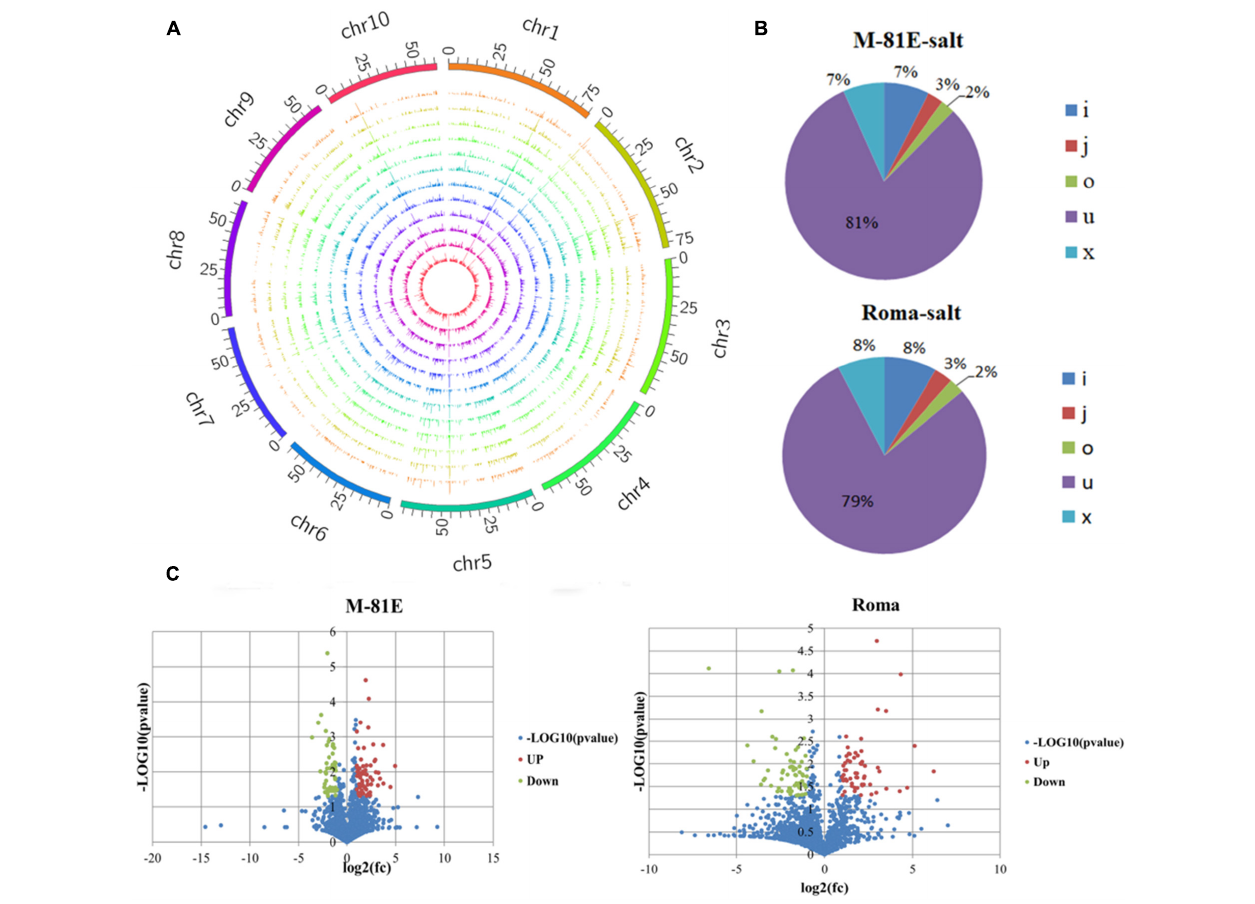
FIGURE 2 | Identification and characterization of DELs. (A) Distribution of lncRNA on the chromosomes. (B) Unique reads mapped to various genomic regions. I, a transfrag falling entirely within a reference intron; j, potentially novel isoform (fragment) with at least one splice junction shared with a reference transcript; o, generic exonic overlap with a reference transcript; u, unknown, intergenic transcript; x, exonic overlap with reference on the opposite strand. (C) Number of DELs identified in M-81E-CK vs M-81E-salt and Roma-CK vs Roma-salt. Among them, the blue points indicate the DELs (–1 > log 2 (fc) > 1), the green points indicate the downward adjustment of DELs (log 2 (fc) < –1, P ≤ 0.05), and the red points indicate the upward adjustment of DELs(log 2 (fc) > 1, P ≤